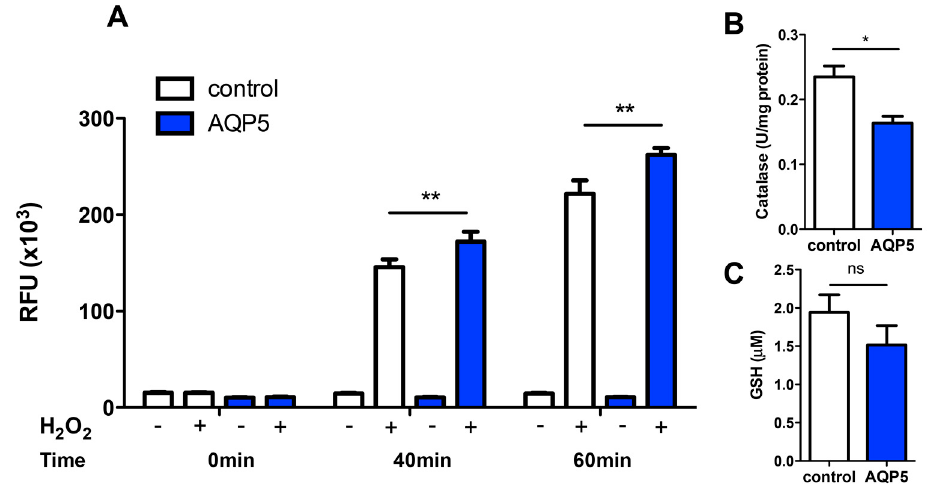
Figure 5. Cellular levels of ROS (oxidant), GSH and catalase (antioxidants). ( A ) Time course of Intracellular ROS production after acute stress induction with 20 mM H 2 O 2 ; ( B ) Catalase activity and ( C ) total intracellular GSH content of yeast strains. Values are means ± SD of triplicates, ns, non significant, * p < 0.05, ** p < 0.01.